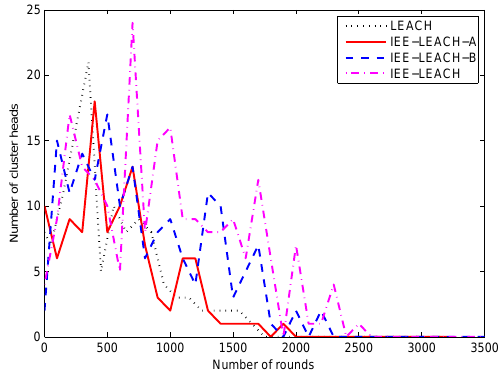
Figure 10. Comparison of the number of cluster